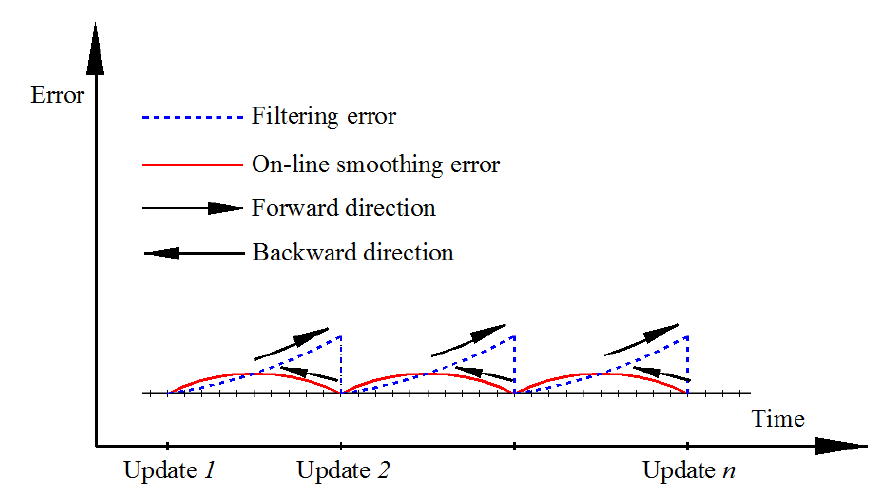
Figure 4. Process and performance of on-line smoothing.